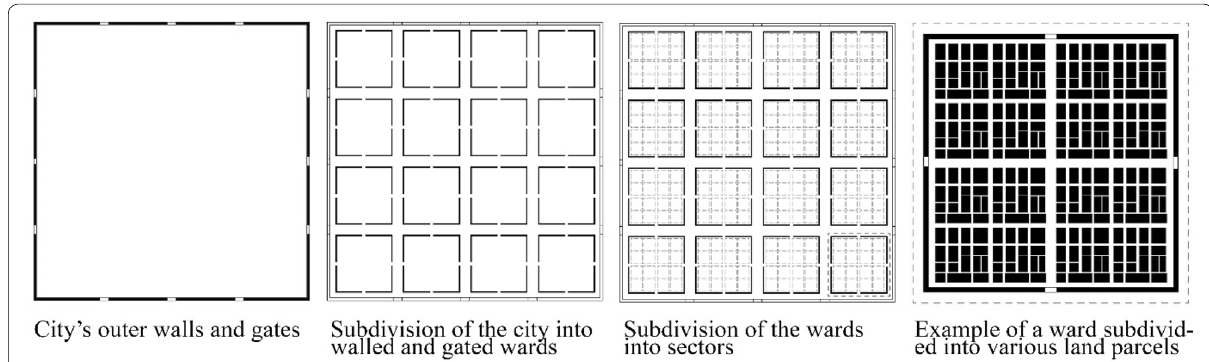
Fig. 1 Schematic representation of the typical structure of a Chinese city during the Tang Dynasty (Source: Hamama 2017)